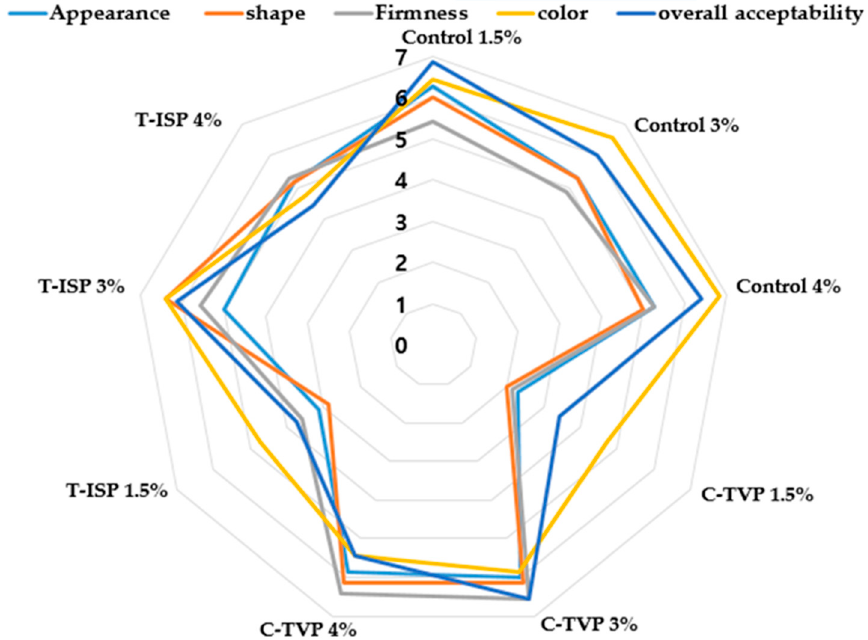
Figure 4. Sensory profile of plant-based meat-based with different soy isolate protein and methyl- cellulose percentage. lulose